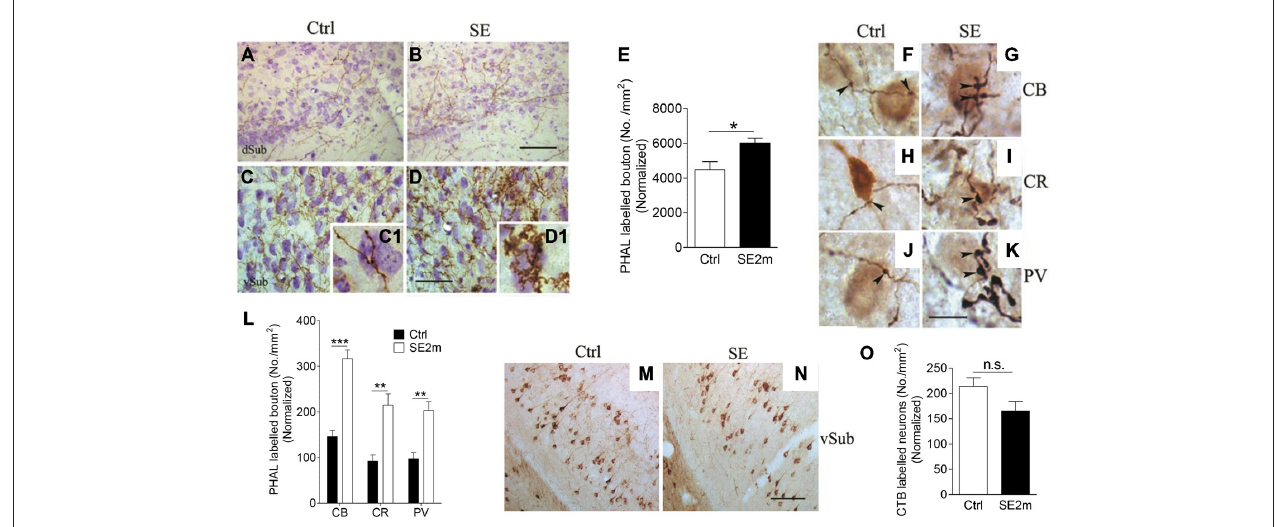
FIGURE 2 | Increased terminal-like structures in the vSub of epileptic mice. Representative images showing PHA-L-immunopositive fibers in the vSub region of control (A,C) or epileptic (B,D) mice. Graph shows density of PHA-L-labeled terminal-like structures in both groups of mice normalized with area shrinkage in the SE2m group (E) (Student’s t -test, ∗ p < 0.05). Representative images showing double immunostaining of CB, CR or PV-positive cells with PHA-L-immunopositive fibers in the control ( F , H and J respectively) and epileptic ( G,I and K respectively) mice. Graph shows quantification of the number of CB, CR or